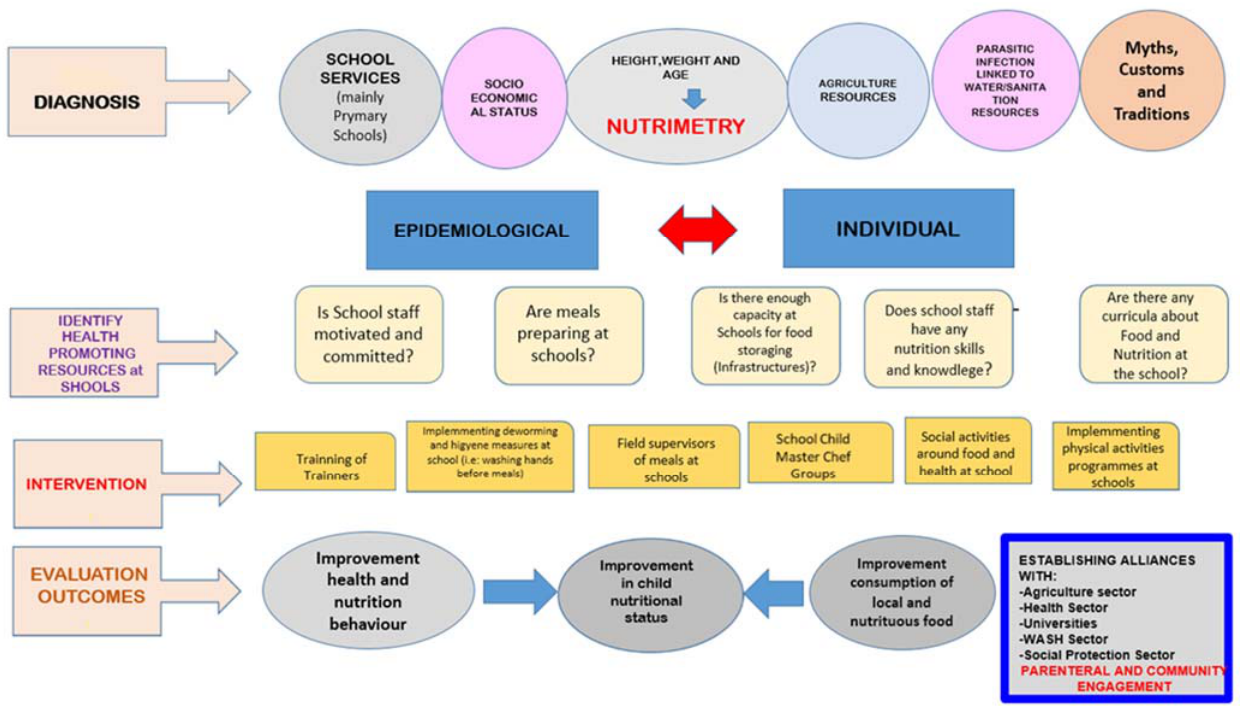
Figure 3. Theoretical framework for the implementation of nutritional and health education in Ecuador focused mainly on primary school environments.